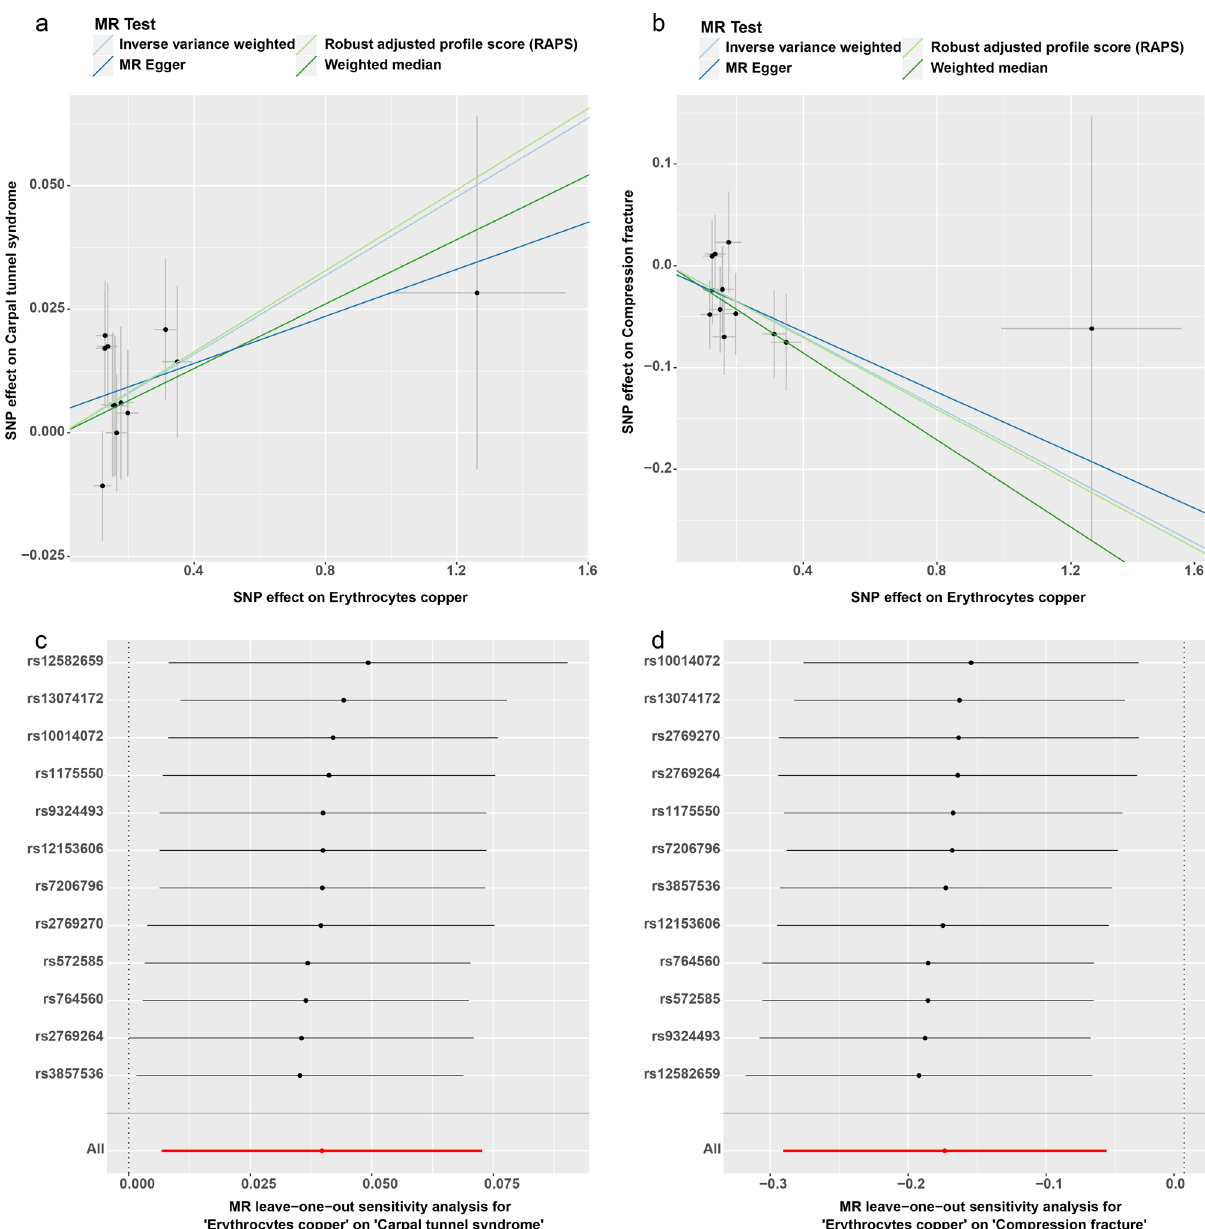
Fig. 5 Scatter and leave-one-out analyses plots for two robust results in the third round two-sample Mendelian randomization analyses. The error bars in panels a and b indicate standard error. The error bars in panels c and d indicate the 95% con fi dence interval. a , c Carpal tunnel syndrome. b , d Compression fracture. MR Mendelian